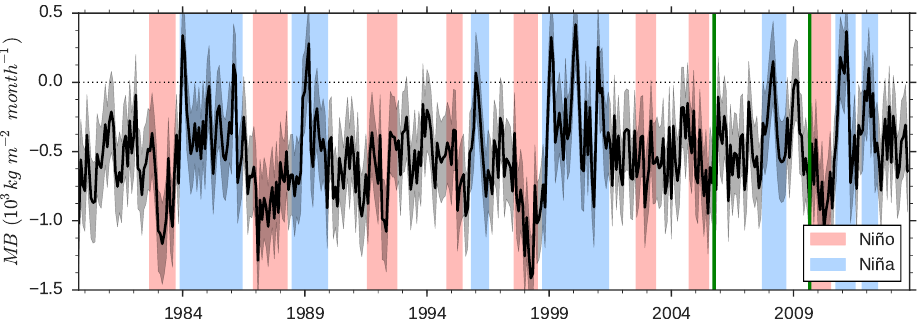
Figure 5. Time series of the computed monthly mass balance at 4750ma . s . l . The grey shading represents ± RMSE (including the RMSE of both the downscaled and the reference data). The calibration period is outlined by the green vertical